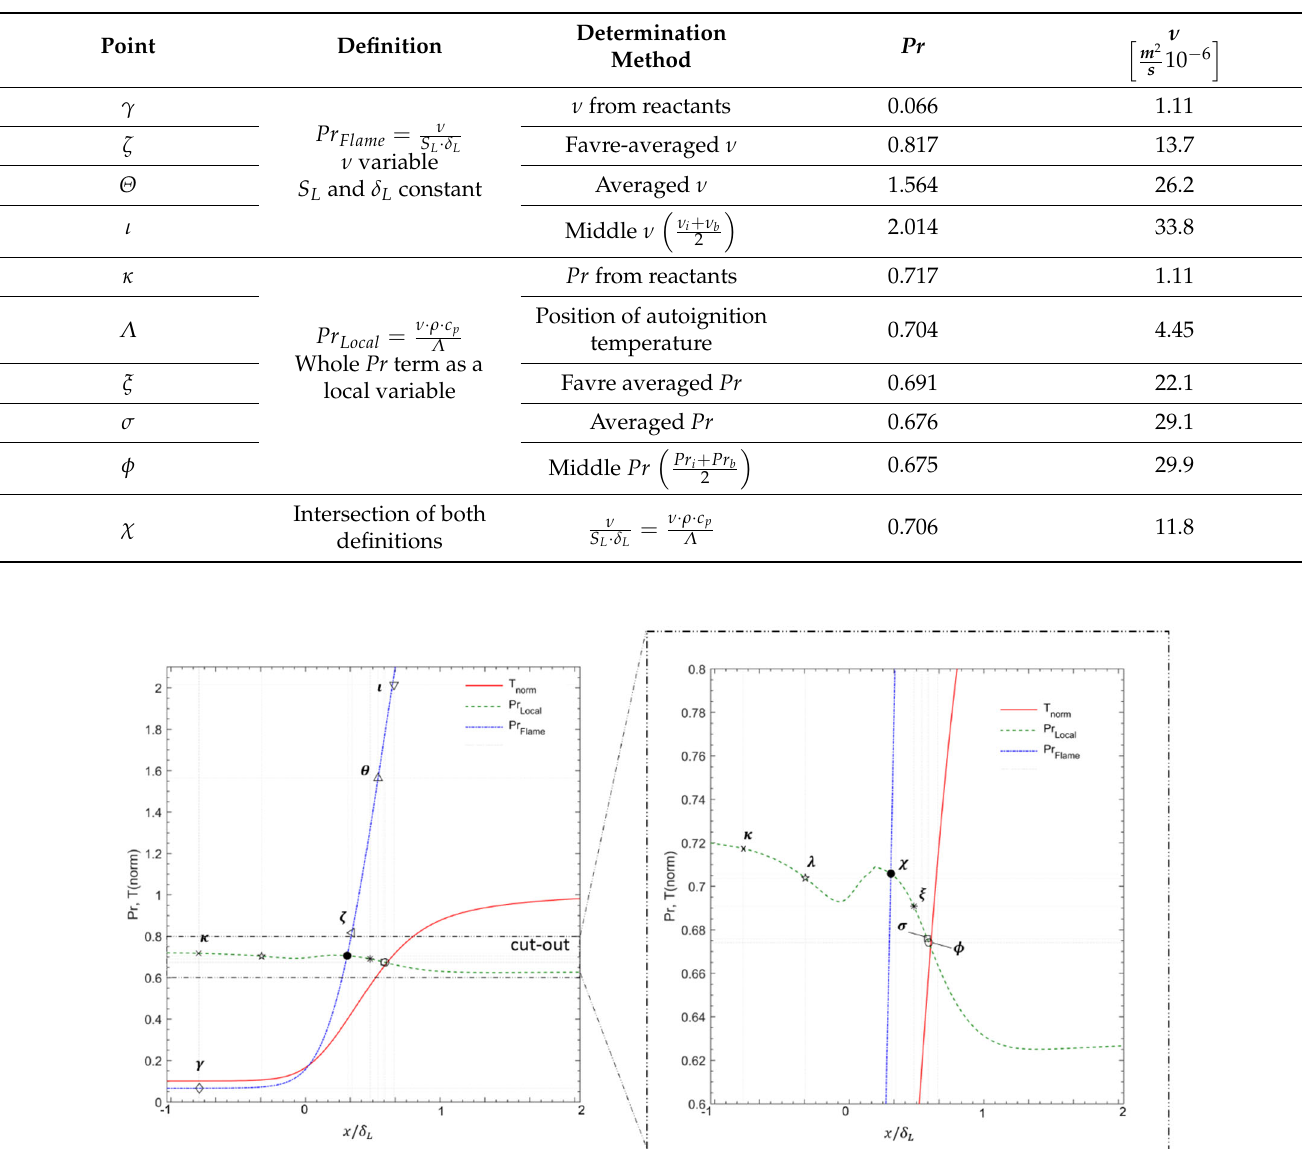
Table 2. Definitions of Pr in Figure 8.